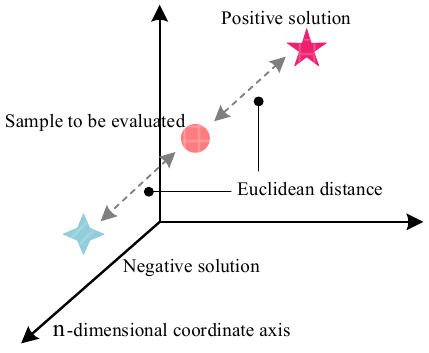
After the safe collision avoidance trajectory is planned, the remaining trajectory meets both vehicle dynamics stability and safe collision avoidance, but it is still a group of trajectory clusters, so it is still necessary to plan the next step in order to solve the optimal lane change trajectory (Figure 8).